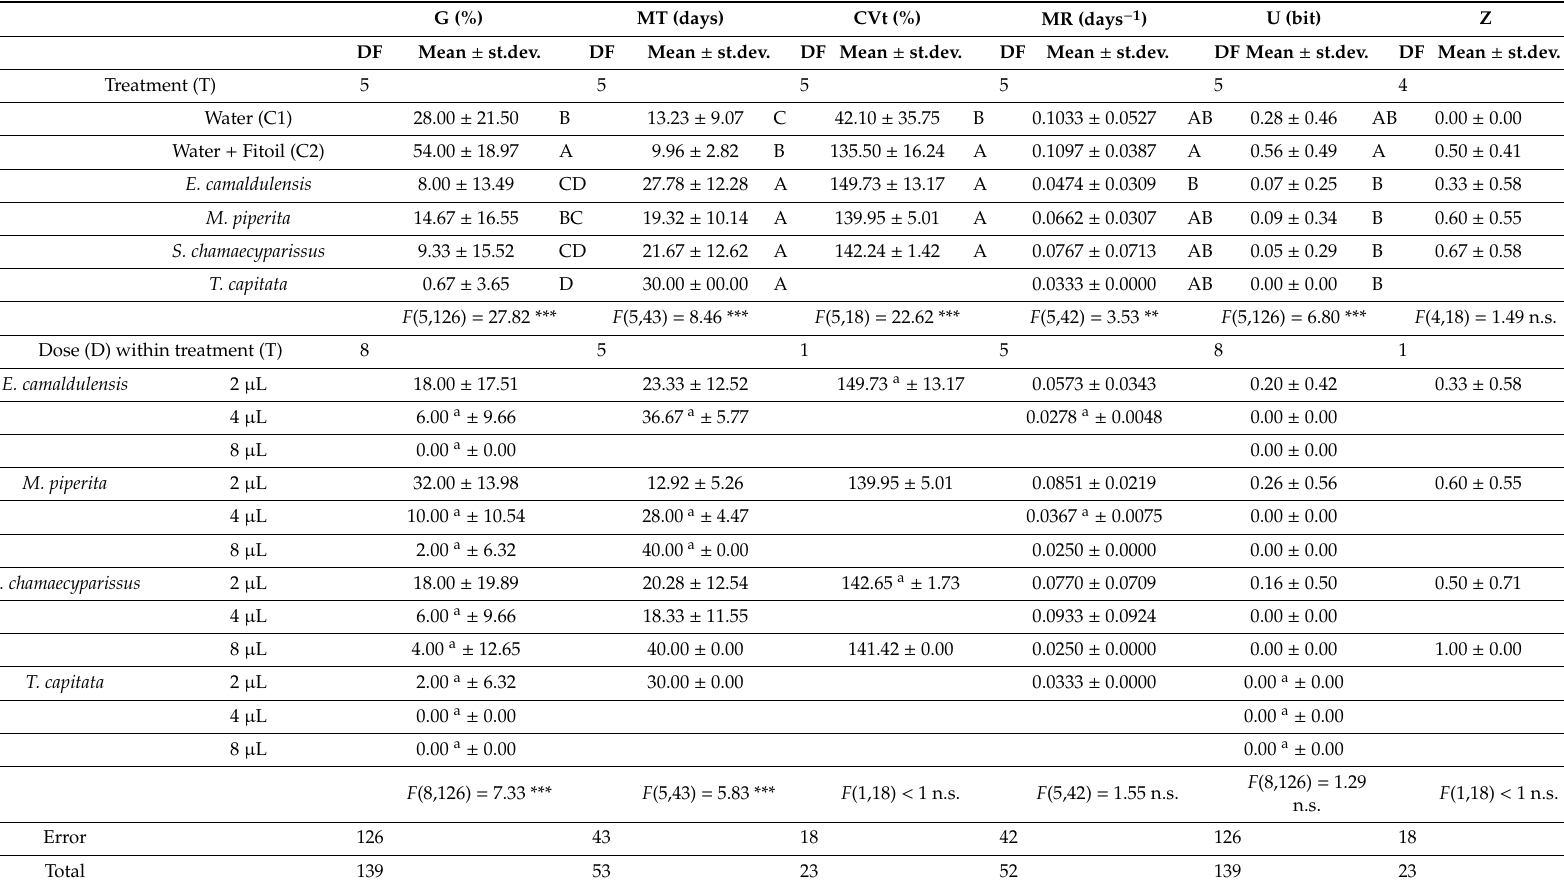
Table 1. Germination measurements (mean ± standard deviation) and results of ANOVA of seeds of Erigeron bonariensis treated in pre-sowing with essential oils (EOs) of Eucalyptus camaldulensis, Mentha piperita, Santolina chamaecyparissus , and Thymbra capitata at di ff erent doses. Treatment means followed by the same letters in each column are not significantly di ff erent at P ≤ 0.05 (Tukey’s test). Within each DxT group, values not followed by the superscript “a” are not significantly di ff erent from the water control (C1) at P ≤ 0.05 (Dunnett’s test). Prior to analyses, percent values were transformed into angular